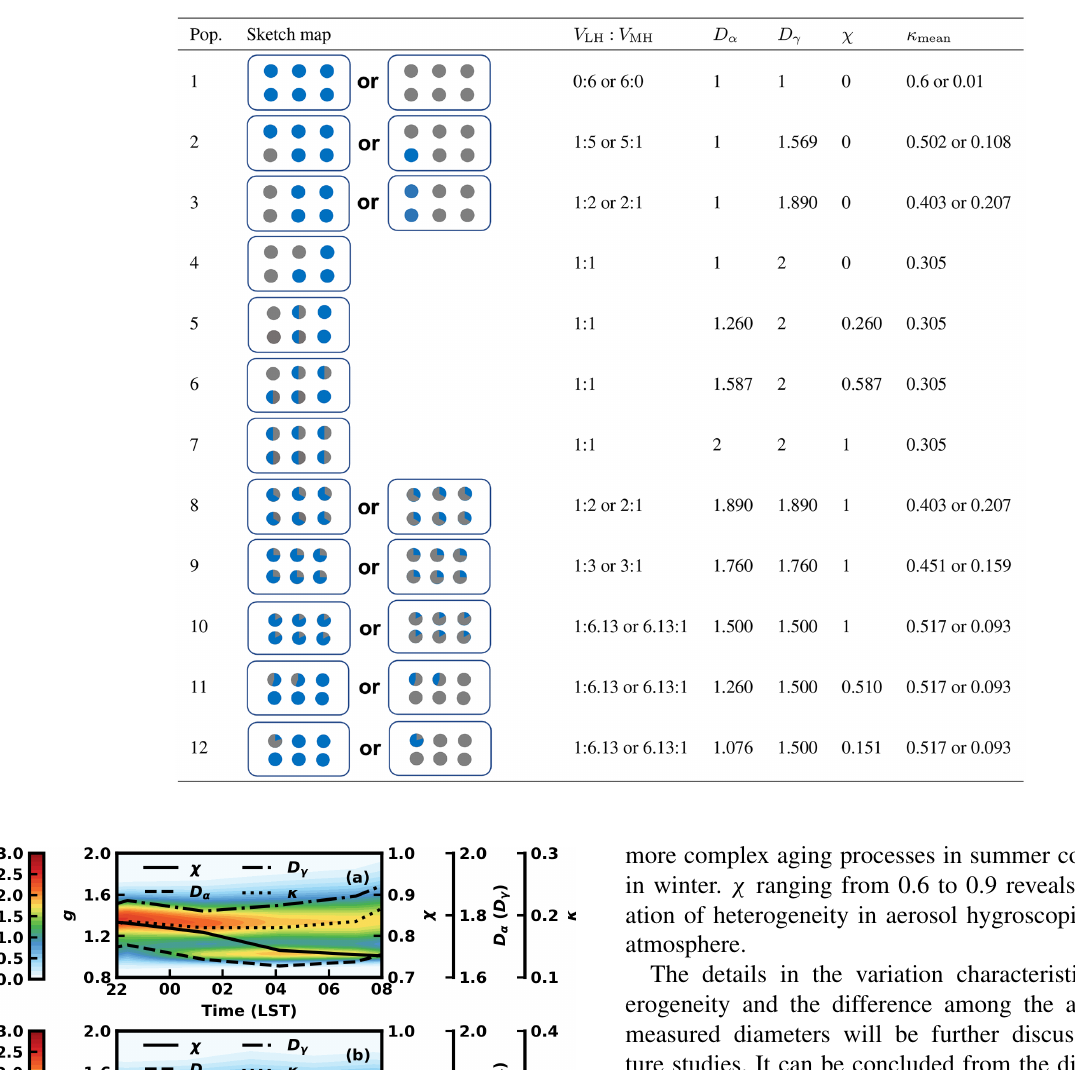
Table 1. The sketch map of the components and the corresponding indices for the 12 different aerosols in Fig. 2. The LH and MH components are represented by the colors gray and blue, respectively; V LH and V MH represent their volumes.